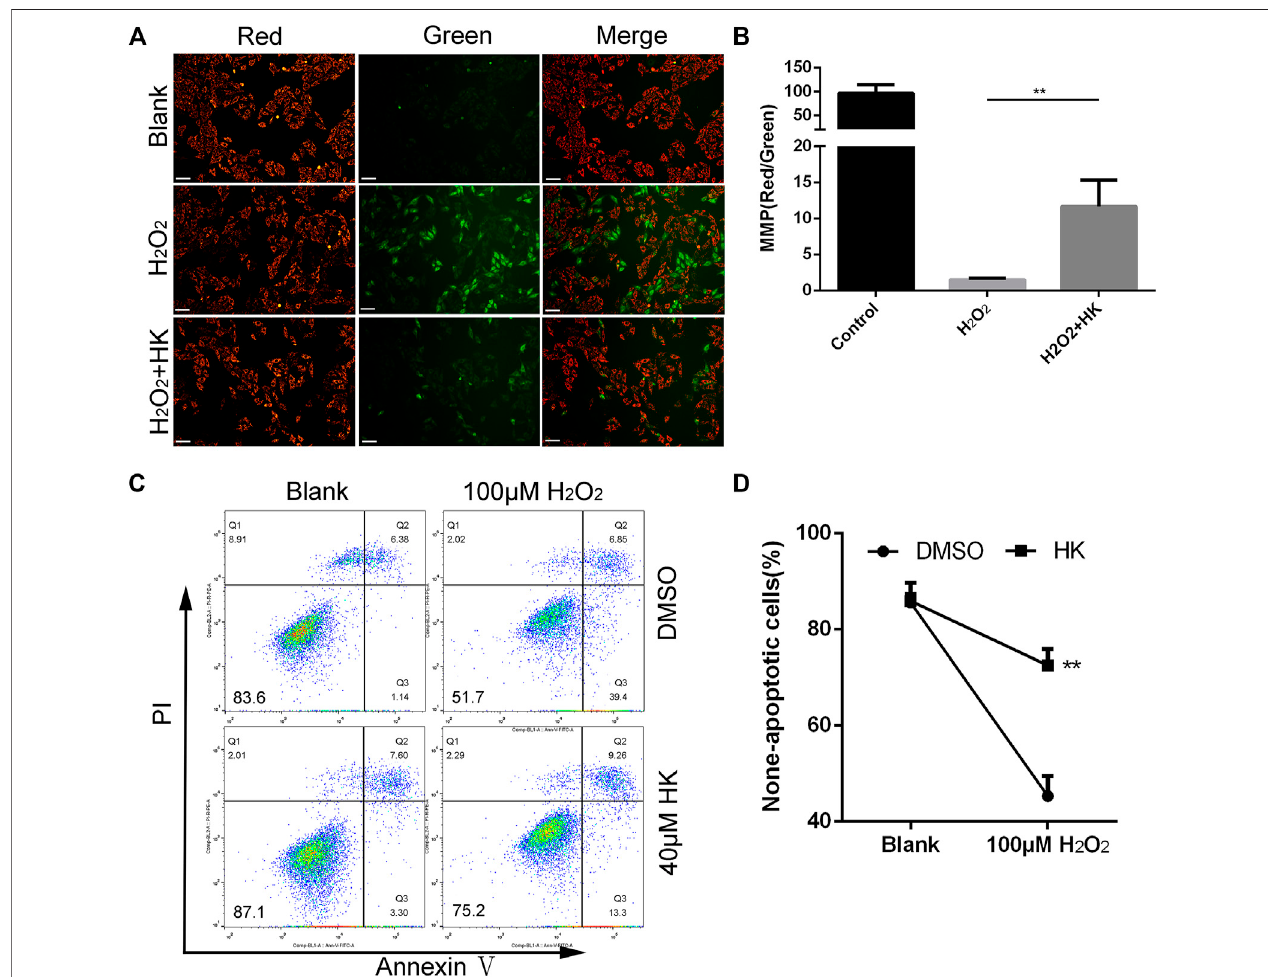
FIGURE 3 | HK normalizes MMP and protects against the apoptosis caused by peroxide in vitro. For MMP detection, primary cardiomyocytes from neonatal mice heartswerecultured inasix-welldishfor12 hinthepresenceorabsenceof40 μ MHK, themedium wasthenreplacedwithnormalmedium containing50 μ Mhydrogen peroxidefor12 htoinduceoxidativedamage. CardiomyocyteswerestainedwithJC-1 tomonitoring theMMP invitro ,scale bar:100 μ m (A) .The fl uorescenceintensity was measured using ImageJ software (B) ( n = 3 per group). For apoptosis detection, cardiomyocytes were cultured in six well dish for 12 h in the presence or absenceof40 μ MHK,themediumwasthenreplacedwithnormalmediumcontaining100 μ Mhydrogenperoxidefor12 htoinduceoxidativedamage.AnnexinV-FITC/ PIApoptosisDetectionKitwereusedforapoptosisassaybyFACSanalysis,datashowquanti fi cationofnon-apoptoticcells (C,D) ( n =3pergroup).Atotalof8,000cells were collected for each sample. Values are shown as means ± SD. * p < 0.05 , ** p < 0.01 vs. H 2 O 2 treatment group.